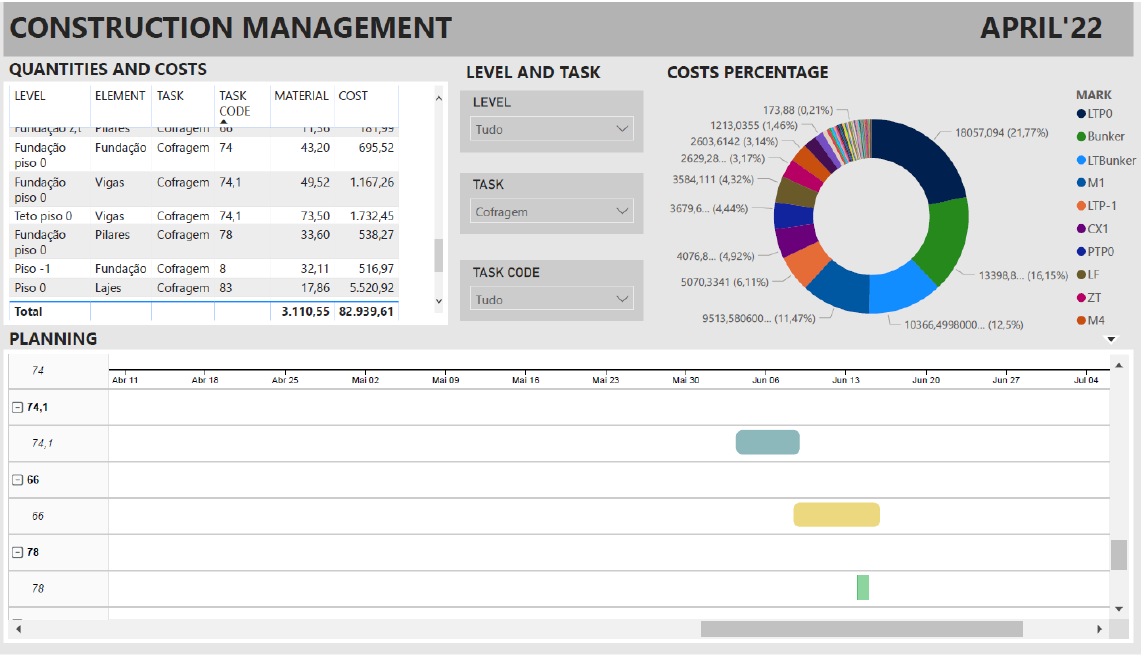
Figure 11. Power BI dashboards—by task code. 4. Discussion As a result of this work, a methodology for construction data visualization, making use of dashboards, demonstrates an important change in the way construction project management can visualize and analyze different types of data integrated into building parametric models or in correlated building models to support decision-making, as dashboards can be used for one building or a set of buildings. The dashboards developed in the scope of this work can be reproduced for other projects since Power BI allows for the models that were developed to update the information after the corresponding data is updated. Additionally, in terms of the Revit modelling, a set of families with the shared